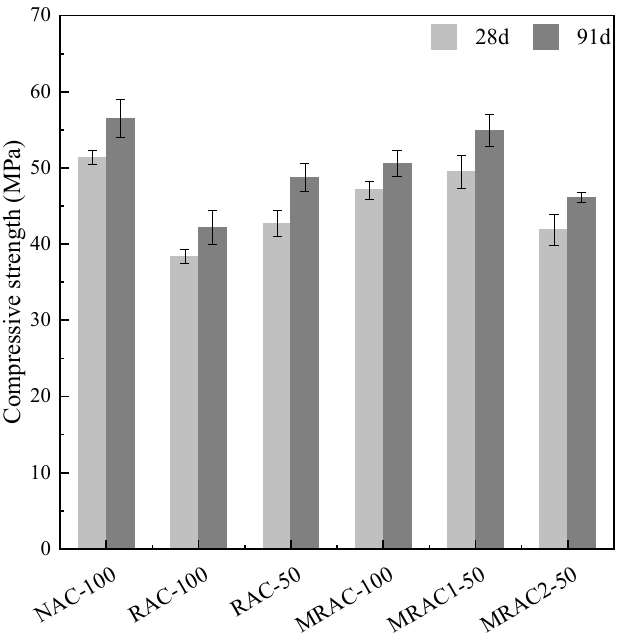
Figure 4. Compressive strengths of RAC.